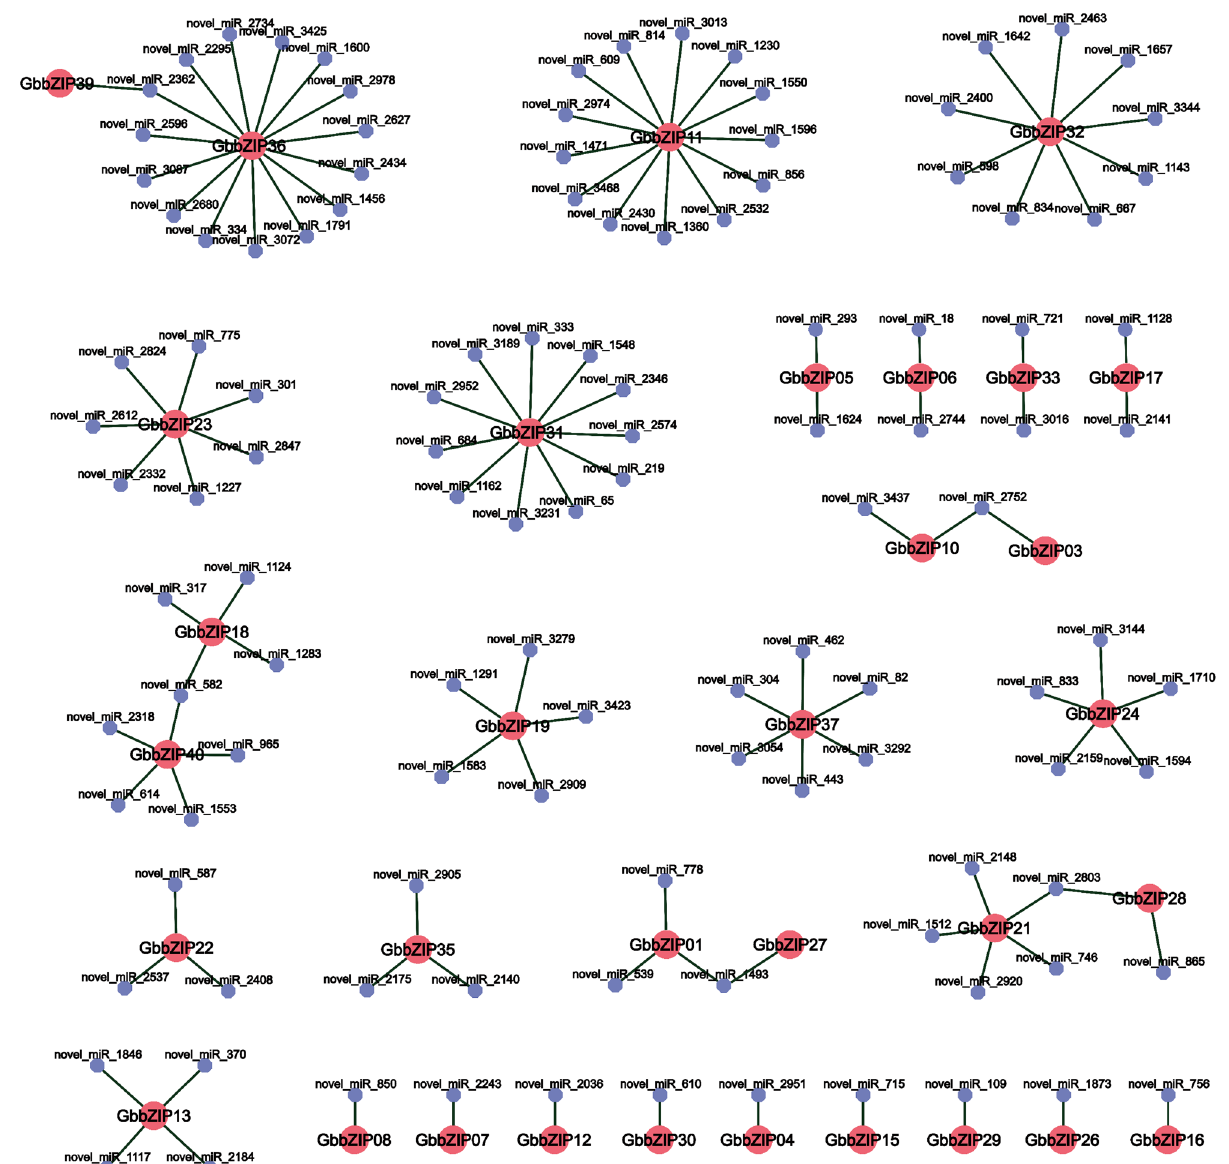
Figure 8. Network diagram of miRNAs targeting GbbZIPs in G. biloba was created using the OmicShare tools (http:// www. omics hare. com/ tools) . Red circle represents GbbZIP members. lilac circle represents miRNAs. The data for the network diagram were obtained from transcriptome and degradome sequencing